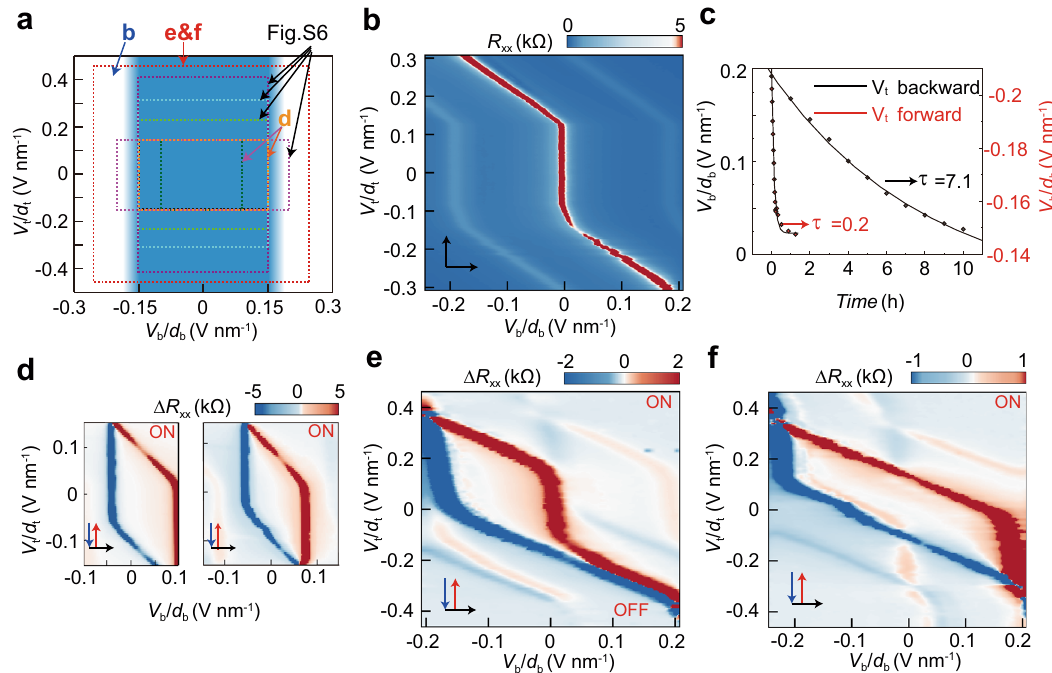
Fig.4|Gate-speci fi cferroelectricitycontrolledbytheothergate.a Tworegimes function are 7.1 and 0.2h, respectively. Measurement details and raw data can be found in Fig. S4. d Below the threshold, a regularparallelogram can be formed. An are identi fi ed according to the stability of the hysteretic behavior. Below the obvious criterion is that the resistance ridge at CNP in the anomalous screening threshold of V b / d b ~0.15Vnm − 1 the ferroelectricity is stable (highlighted in blue), whereas it becomes more and more fragile when exceeding the threshold. The regimeisstrictlyparallelwiththe y axis.Herethescanningrangeof V b / d b is0.1(left) scanning ranges usedin other panelsand Fig. S6are denoted. b Take the scanning and 0.15 (right) V nm − 1 . The label ON/OFF means hysteresis loops are switched on/ range of V b / d b as above 0.2Vnm − 1 , one obtains a phase diagram without ferro- off. e In a larger scanning range of V b ~0.21Vnm − 1 , the relaxation distorts the electric hysteresis by scanning V t / d t slowly (see its hysteresis-free counterpart in parallelogram in the upper-left corner of the V t - V b phase diagram, i.e ., the ridge is Fig.S3).However,theanomalousscreeningremainsrobust. c Therelaxationtothe no more in parallel with the y axis; furthermore, it eliminates completely the hys- stable states shown in b is quanti fi ed by a temporal characterization. Two repre- teresis in the lower-right corner. f By increasing the scanning rate through a par- sentativepointsare selected:oneisfor V t >0inthebackwardscanandtheotheris ticularscheme(seedetailsinFig.S5),therelaxationcouldbeovercomeandhencea V fi tted by an exponential decay full hysteresis loop is t <0 in the forward scan. The characteristic time